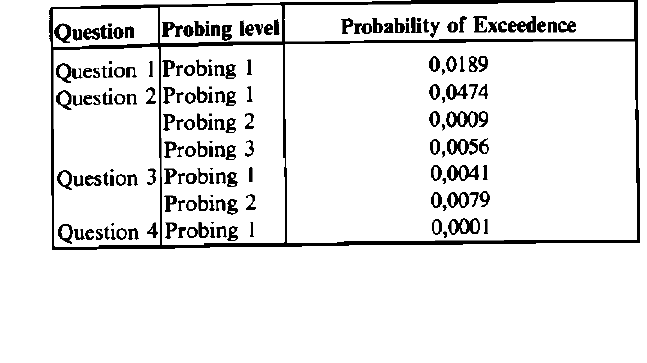
Table 5: Partial correlation between PPVT-R scores and accuracy of comprehension questions when probing is held